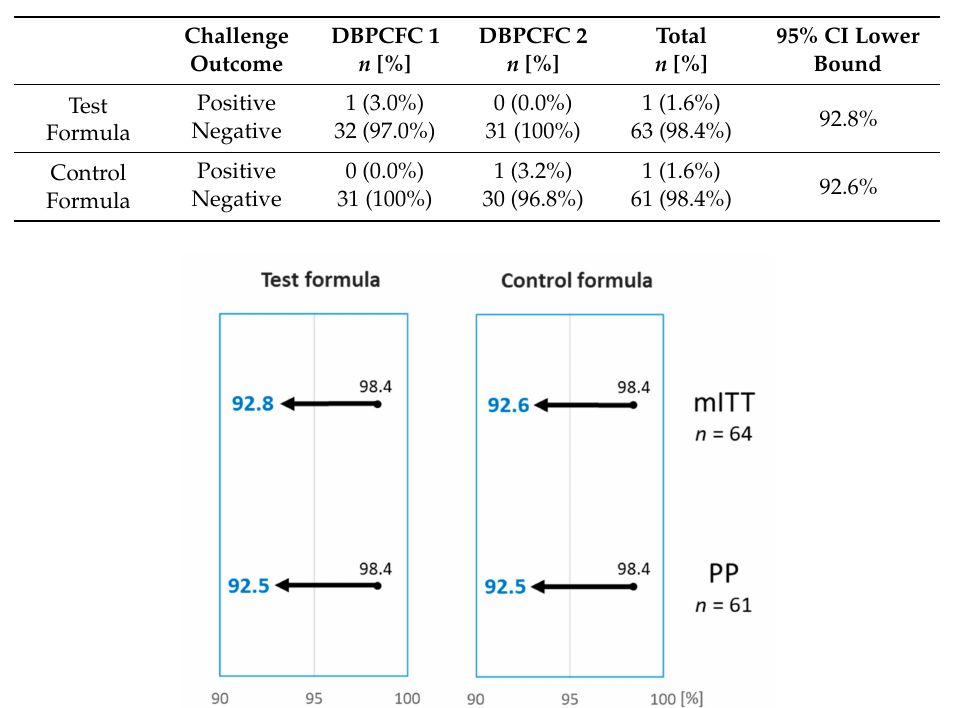
Table 2. Outcome of DBPCFC to the Test and Control formula by group allocation in the modified intention-to-treat (mITT) cohort. The 95% confidence interval lower bound was greater than 90% for both formulas.